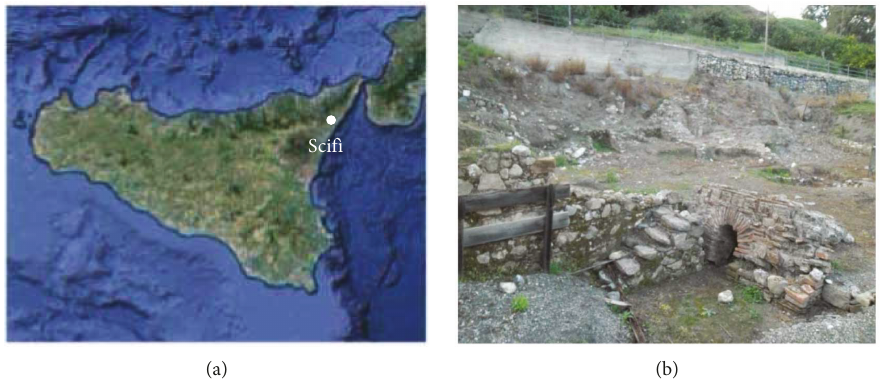
Figure 1: (a) Map of Scifì (Forza d ’ Agrò, province of Messina, Italy). (b) The archaeological site of